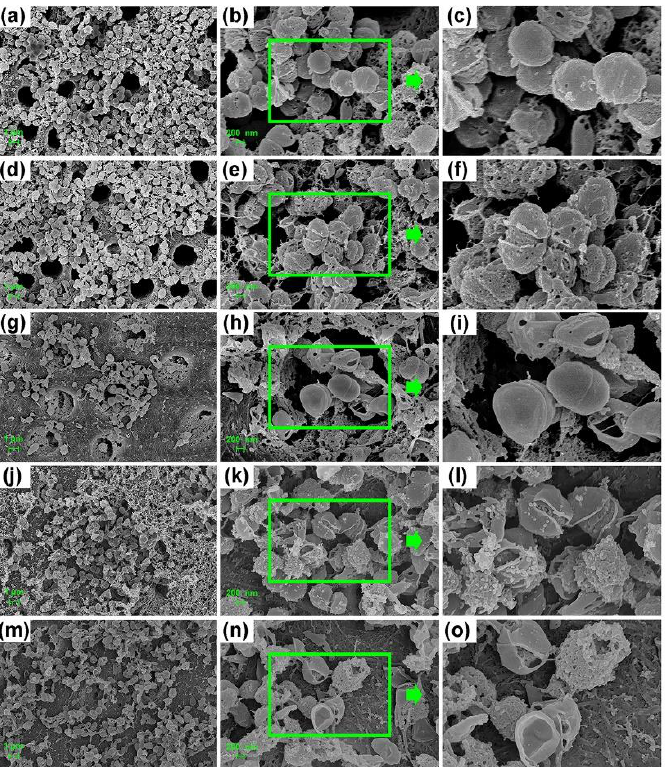
Figure 4. FE-SEM images of dentin biofilm in high-glucose BHI. ( a – c ) Biofilm treated with PBS gel (blank control); ( d – f ) Biofilm treated with 0.04% TX-100 gel; ( g – i ) Biofilm treated with 100 mg/mL Met gel; ( j – l ) Biofilm treated with 2% CHX gel; ( m – o ) Biofilm treated with synergistic gel (0.04% TX-100 + 100 mg/mL Met) (magnifications are 5000×; 20,000×; zoom in).